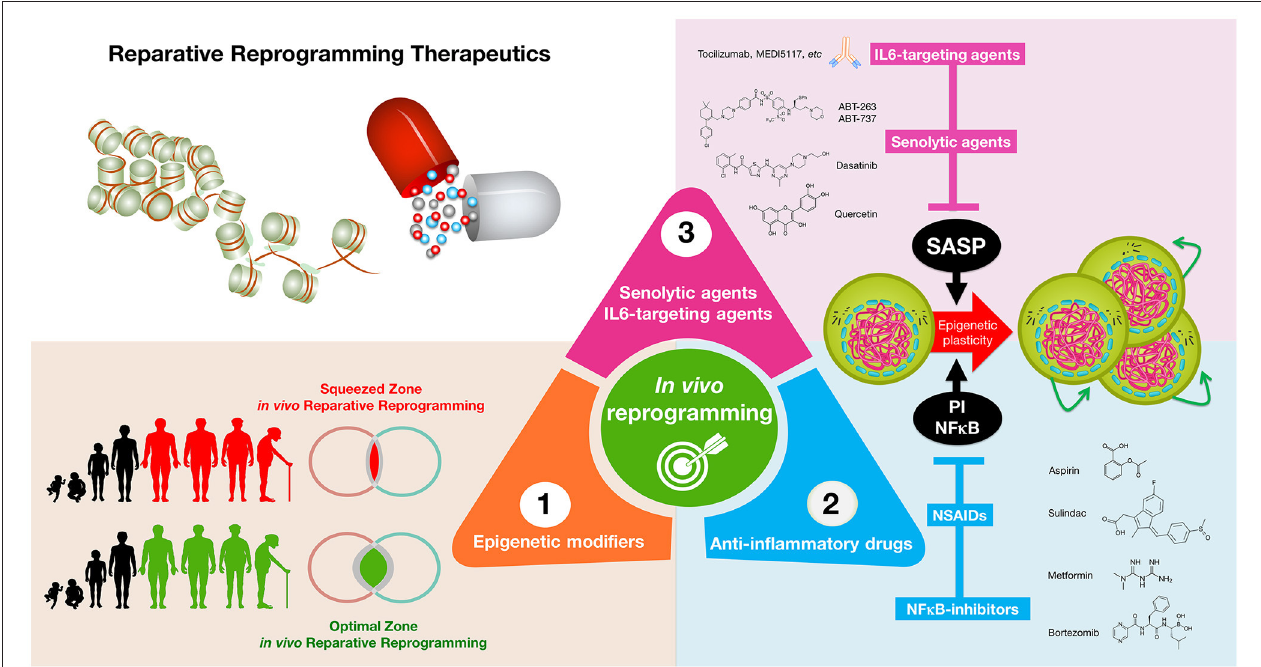
FIGURE 3 | Reparative reprogramming therapeutics: enhancing the body’s self-cell therapy for resistance to damage and disease. A cellular reprogramming-centered view of epigenetic plasticity as a fundamental dimension of a tissue’s capacity to undergo successful repair may provide new therapeutic approaches for aging and cancer. (1) Epigenetic modifiers: small molecules capable of mimicking the transient amelioration of tissue functions occurring upon short-term induction of OSKM-induced nuclear reprogramming (Mahmoudi and Brunet, 2016; Ocampo et al., 2016) might increase epigenetic plasticity and to enhance regeneration in aging tissues; (2) anti-inflammatory drugs: NF κ B-targeting drugs and commonly employed NSAIDs might help reduce some aging- and cancer-promoting inflammatory feedback loops to reestablish the functioning of reparative reprogramming; (3) IL-6-targeting and senolytic agents: IL-6 blockade and senescent cell ablation might help unlock the chronic epigenetic plasticity of SASP-damaged tissues to successfully achieve tissue rejuvenation if accompanied by reparative differentiation phenomena.